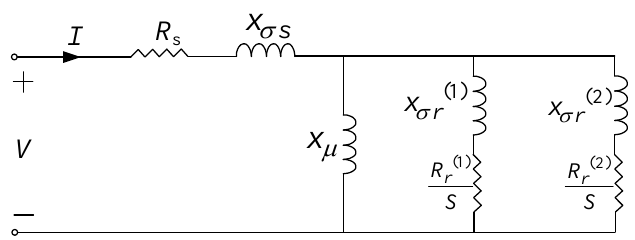
Figure 1. Equivalent circuit for the three-phase induction motor.